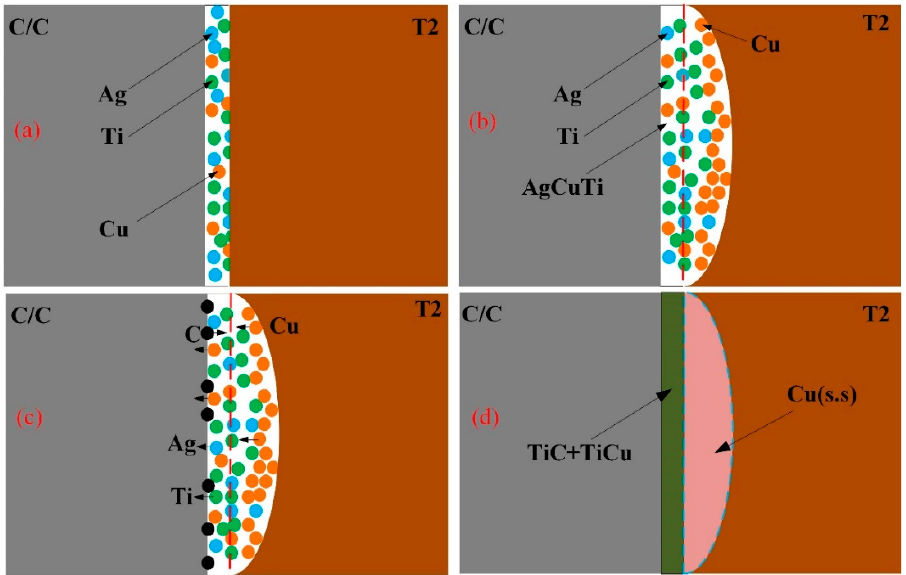
Figure 14. Schematic diagram of interface evolution model. ( a ) the interface before the formal welding, ( b ) the interface during welding, ( c ) atomic diffusion at the interface, and ( d ) the ultimate reaction layer at the interface.